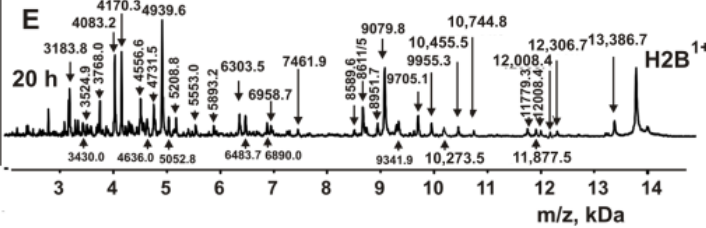
Figure 7. MALDI spectra show H2B histone (0.8 mg/mL) over time hydrolysis (0–20 h) in the absence ( A ) and in the presence of HIV-infected patients IgGs (0.045 mg/mL) against H2B ( B ), MBP ( C ) and DNA ( E ). ( D ) shows H2B histone cleavage with MS patients IgGs against MBP. All used IgG preparations, and m/z of hydrolysis products (Da) are indicated on the panels. Based on a set of data from 7–10 spectra after 3–20 h of H2B hydrolysis with these antibodies, the sites of hydrolysis of this histone were found (Figure 8).